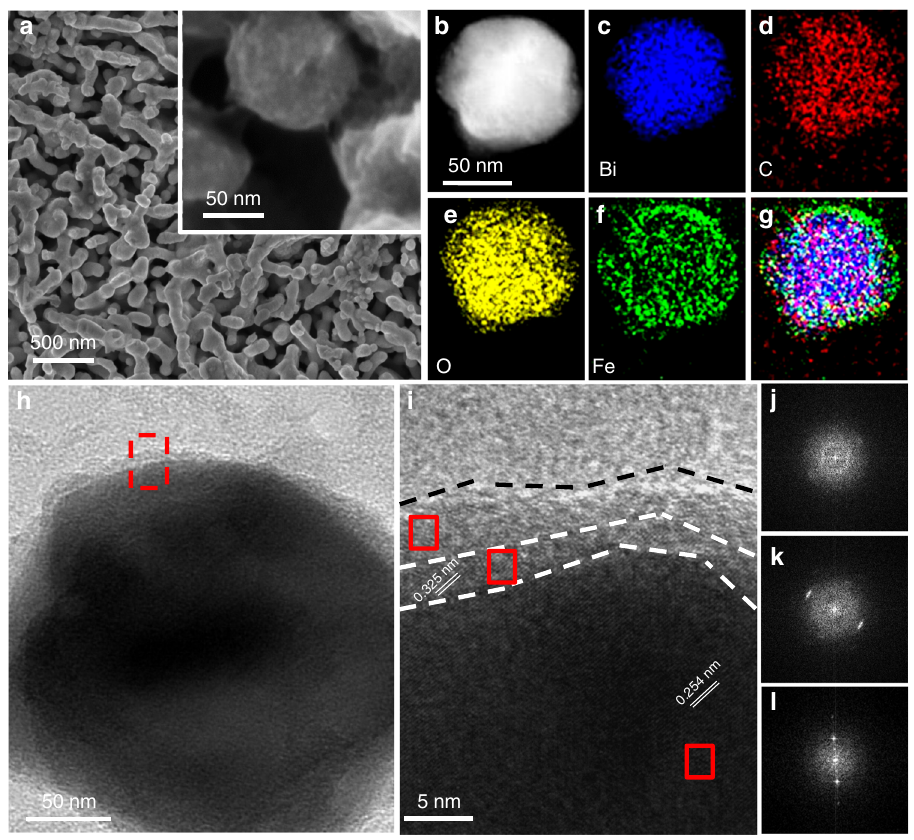
Fig. 1 Electron microscopic characterization of the NiFeO x /B-C 3 N 4 /Mo-BiVO 4 photoanodes. a Top-view (inset is the magni fi ed image) SEM images of the NiFeO x /B-C 3 N 4 /Mo-BiVO 4 photoanode. b HADDF-STEM image of the NiFeO x /B-C 3 N 4 /Mo-BiVO 4 photoanode and c – f the corresponding STEM-EDS elemental mapping images for Bi, C, O, and Fe, respectively. g Overlay of the elemental mapping images of Fe, C, and Bi. h TEM, i HRTEM image of the NiFeO x /B-C 3 N 4 /Mo-BiVO 4 photoanode and j – l corresponding diffraction patterns via fast Fourier transform of NiFeO x , B-C 3 N 4 , and Mo-BiVO 4 ,